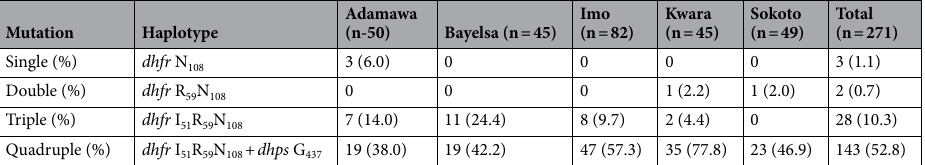
Table 3. Prevalence of combine dhfr + dhps mutant